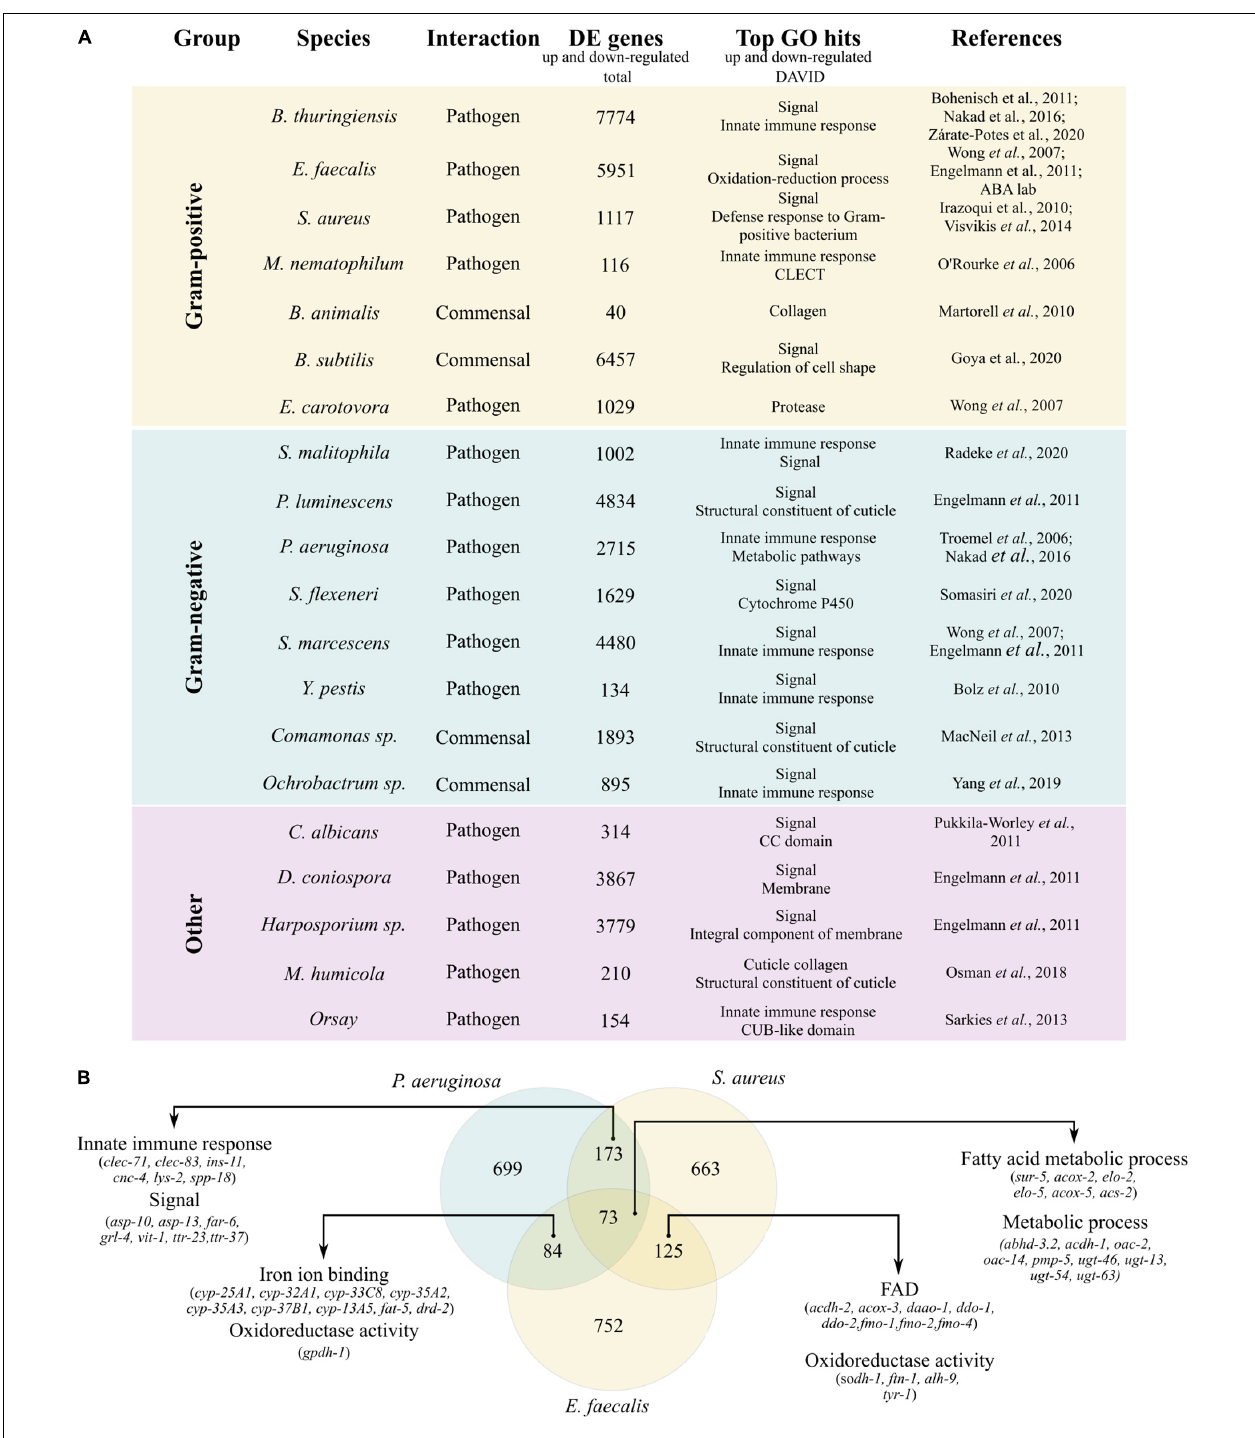
FIGURE 1 | Gene expression changes of C. elegans exposed to diverse microbes. (A) Shows a list of 20 different microbes for which gene expression data of exposed C. elegans is available. The table includes: The nature of the interaction with C. elegans , either pathogenic or commensal; the total number of unique significantly differentially expressed (DE) genes combining all different time points and datasets; the top two hits of gene set enrichment analysis performed with the online tool DAVID (https://david.ncifcrf.gov/) using the unique set of DE genes per microbe (both up- and down-regulated together) (the complete results of the enrichment analysis can be found in Supplementary Table 3 ); and the references from which the datasets were obtained. In (B) a Venn diagram showing the overlaps between the list of unique DE genes of C. elegans exposed to P. aeruginosa , E. faecalis, and S. aureus . The top two hits of the enrichment analysis using DAVID and representative genes for each enrichment term are shown. A full gene ID list and the full results of the enrichment analysis are shown in Supplementary Table 3 .